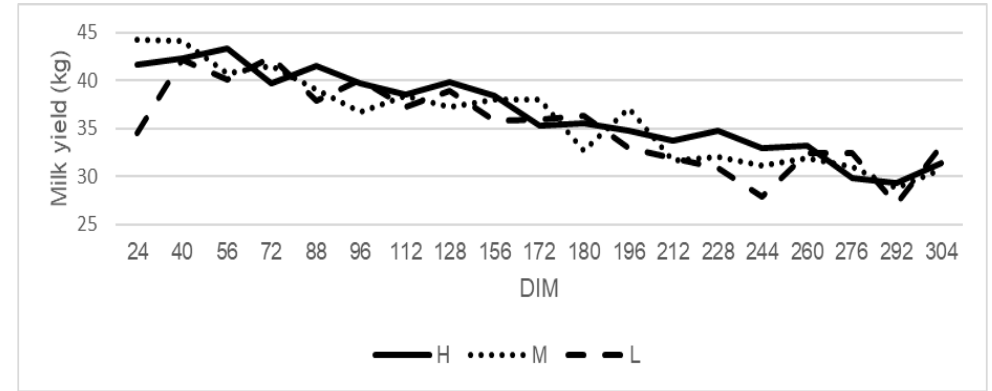
Figure 3. The trend for milk production in cows classified as high (H), medium (M), and low (L) rumination animals. High rumination (H) from 527 min/day, medium rumination (M) from 412 to 527 min/day, and low rumination (L) to 412 min/day.